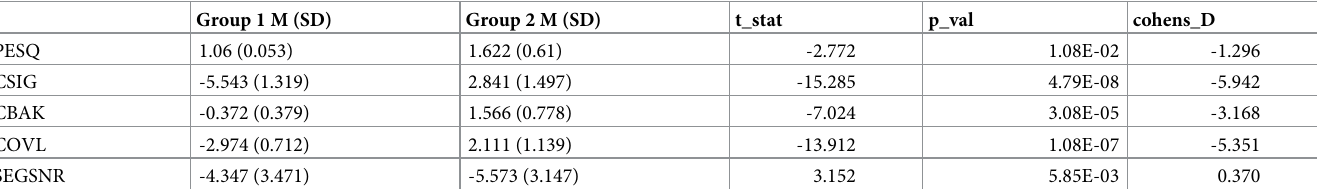
Paired sample t-test results for all speech quality metrics. Group 1 represents TorchDIVA output with no enhancement, while Group 2 represents the DiffWave- enhanced speech. The final column of the table contains the Cohen’s D (effect